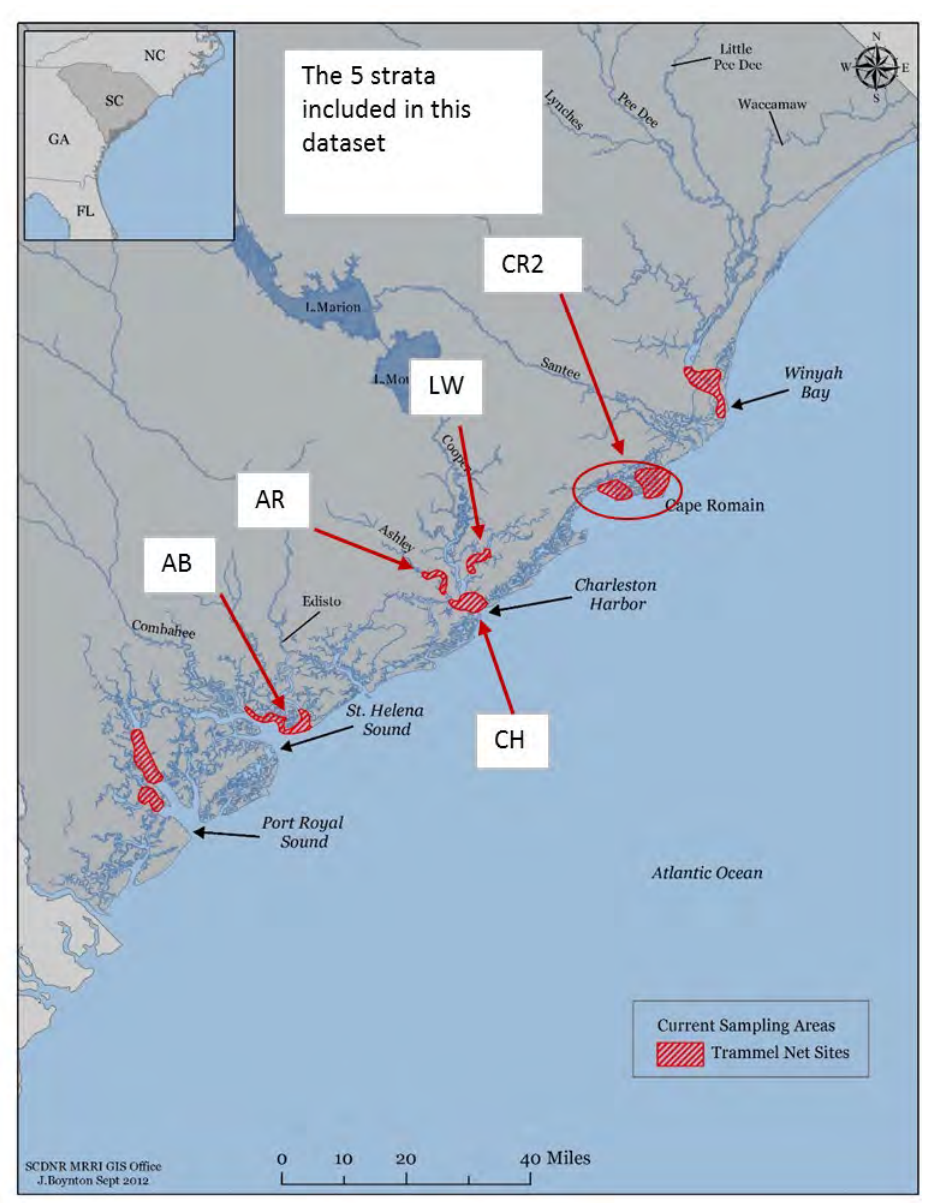
Figure 66. Areas samples by the trammel net, electrofishing, and long-line surveys of the SC DNR Inshore Fisheries Section. Trammel net strata used for analyses in this report: AB - ACE Basin; AR - Ashley River; CH - Charleston Harbor; LW - Lower Wando River; CR2 - Cape Romain (map provided by SC